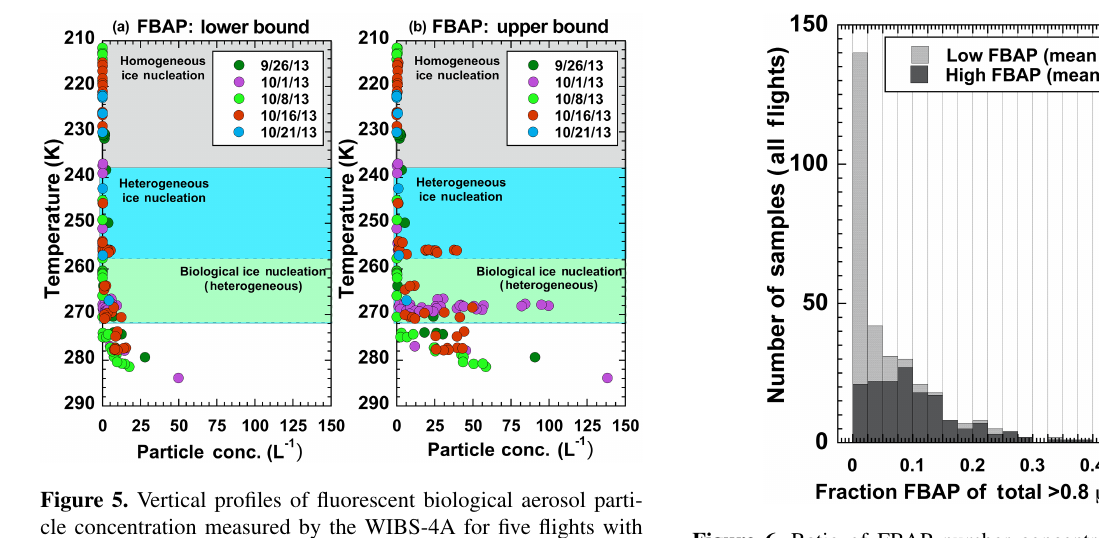
Figure 6. Ratio of FBAP number concentration to total particle number concentration in the 0.8–12µm size range, using expected low and high bounds as discussed in the text. Histograms of 200s average values for WIBS-4A samples on all five flights are plotted. Legend shows the mean fraction for each FBAP